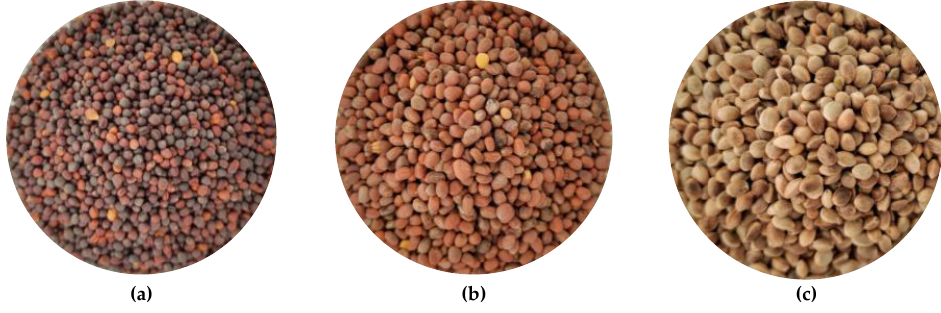
Figure 2. Oilseeds used: ( a ) rape; ( b ) oilseed radish; ( c ) hemp.